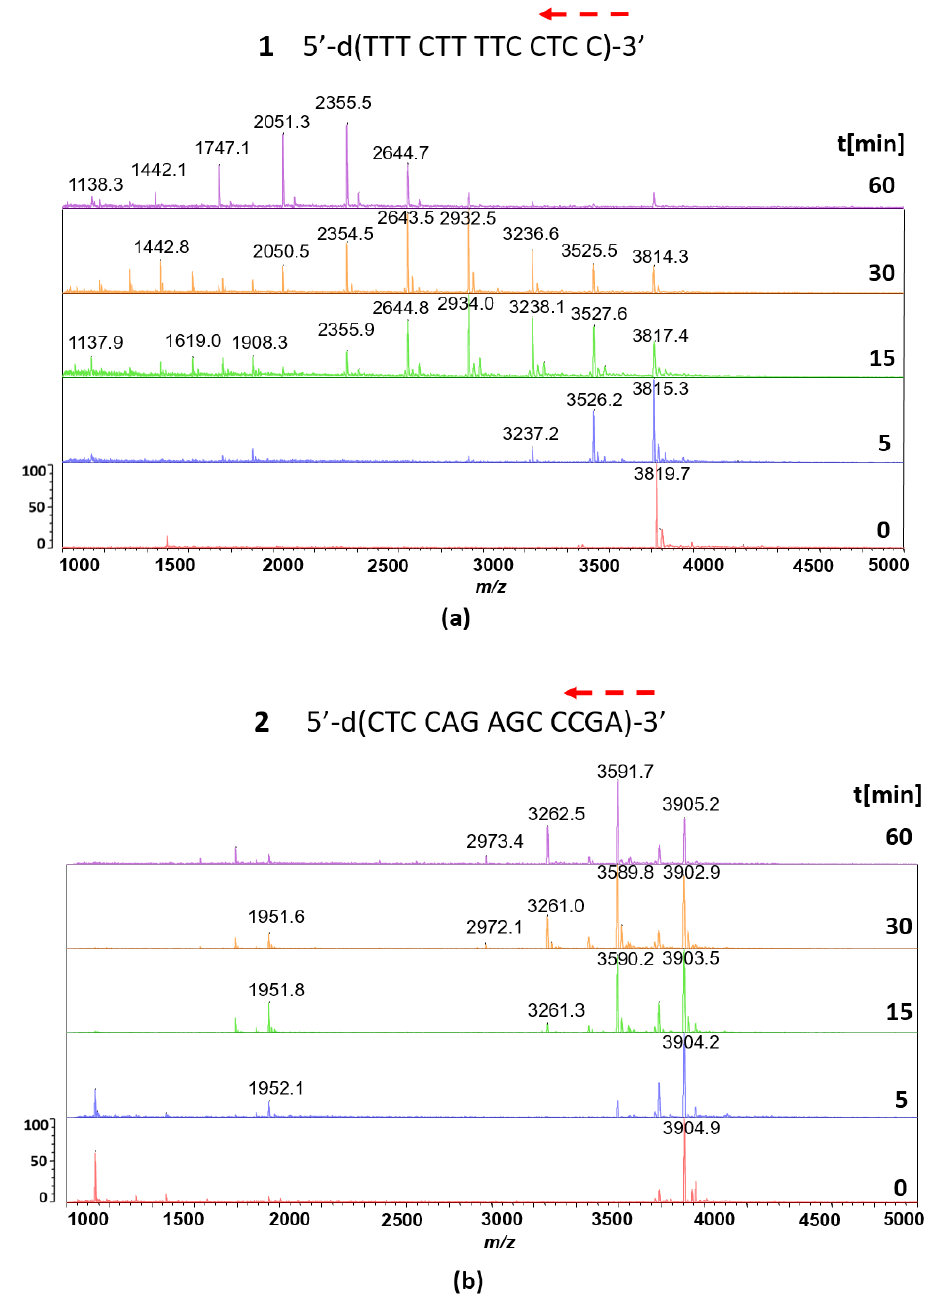
Figure 1. MALDI-TOF mass spectra of the reaction mixtures of the 3’ → 5’ exonucleolytic hydrolysis of oligonucleotides 1 ( a ) and 2 ( b ) in the presence of svPDE. Samples were analyzed at 0, 5, 15, 30 and 60 min.